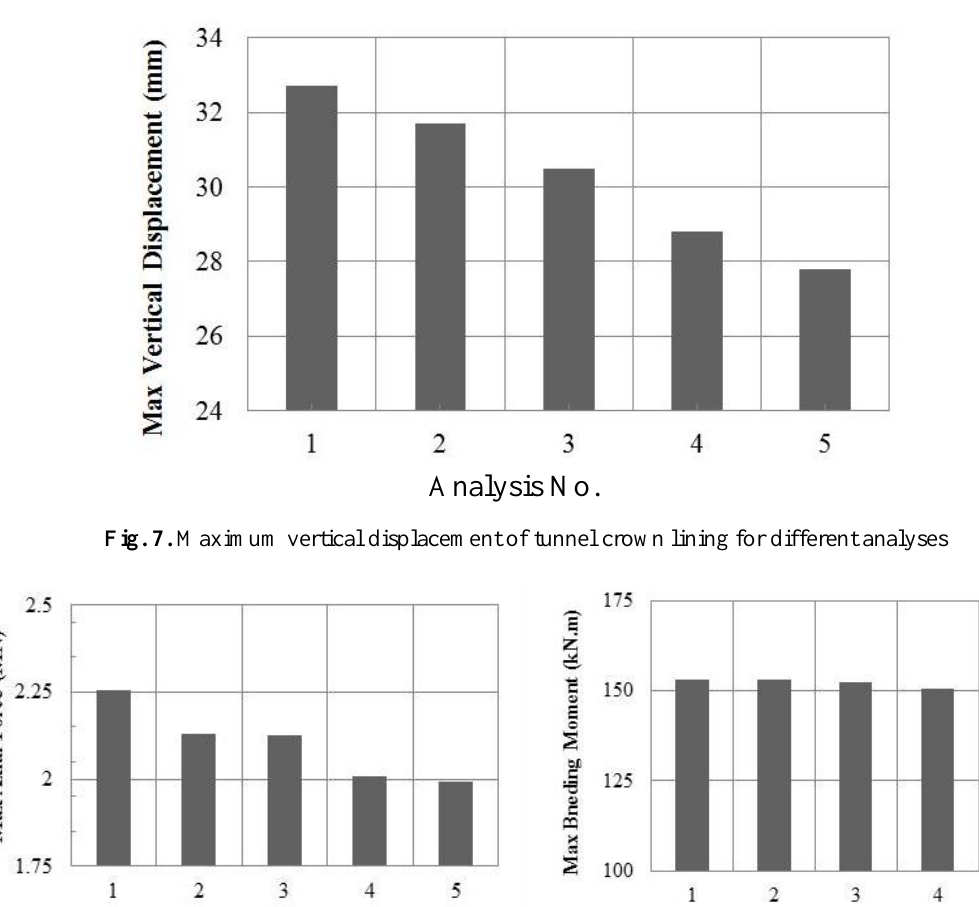
Analysis Fig. 8. Presentation of maximum values of (a) axial force; (b) bending moment of tunnel crown lining for different analyses